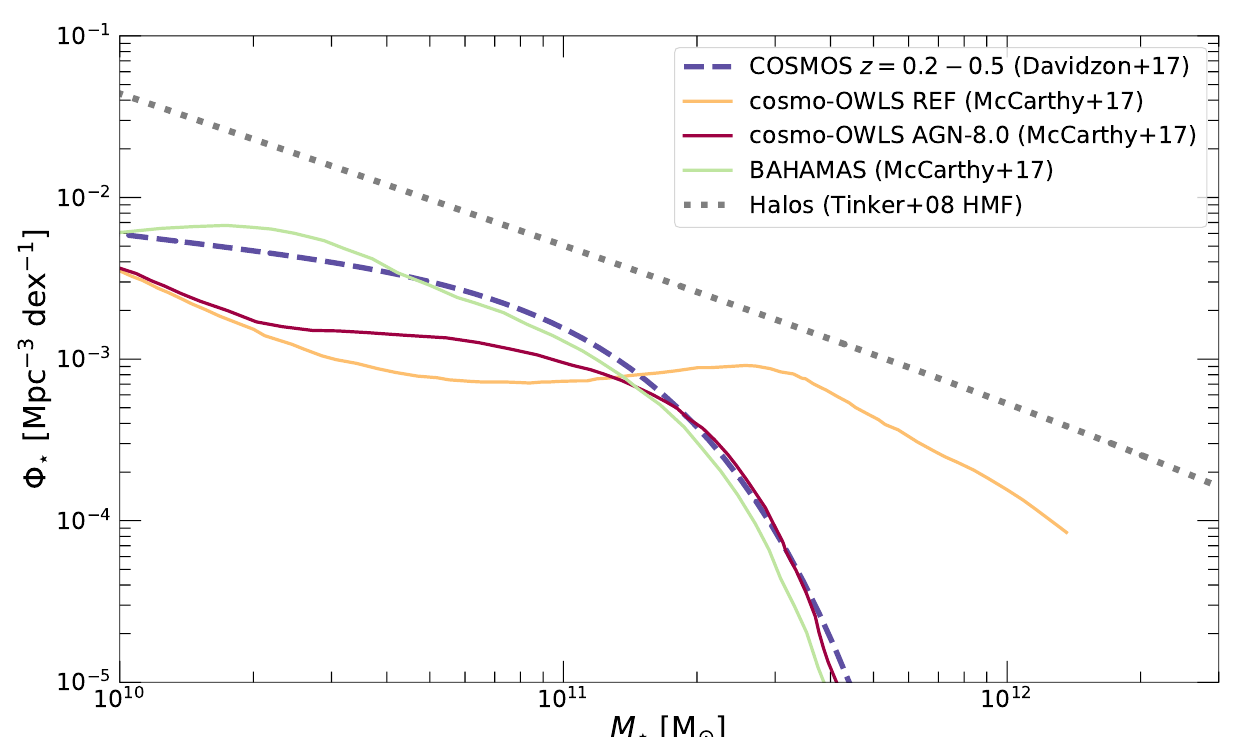
Figure 1. Galaxy stellar mass function (GSMF) Φ (cid:63) ( M (cid:63) ) = dN in observations and simulations. The dashed purple dM ∗ dV curve shows the double-Schechter fit to the local GSMF measured in the COSMOS survey [3]. The solid curves show the predictions of the cosmo-OWLS/BAHAMAS model [12,41] in the case with only stellar feedback (REF, yellow), cosmo- OWLS with AGN feedback (AGN-8.0, maroon), and the latest BAHAMAS model (green), in which the feedback model was tuned to reproduce jointly the GSMF and the gas fraction. For comparison, the dotted gray curve shows the Tinker et al. [42] halo mass function in Planck cosmology scaled by f b = Ω b / Ω m , which highlights what one expects to see in the case in which each halo is populated by a galaxy with M (cid:63) = f b M h